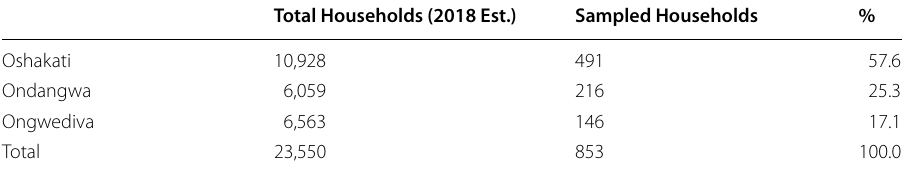
Table 2 Corridor households and sample size Total Households (2018